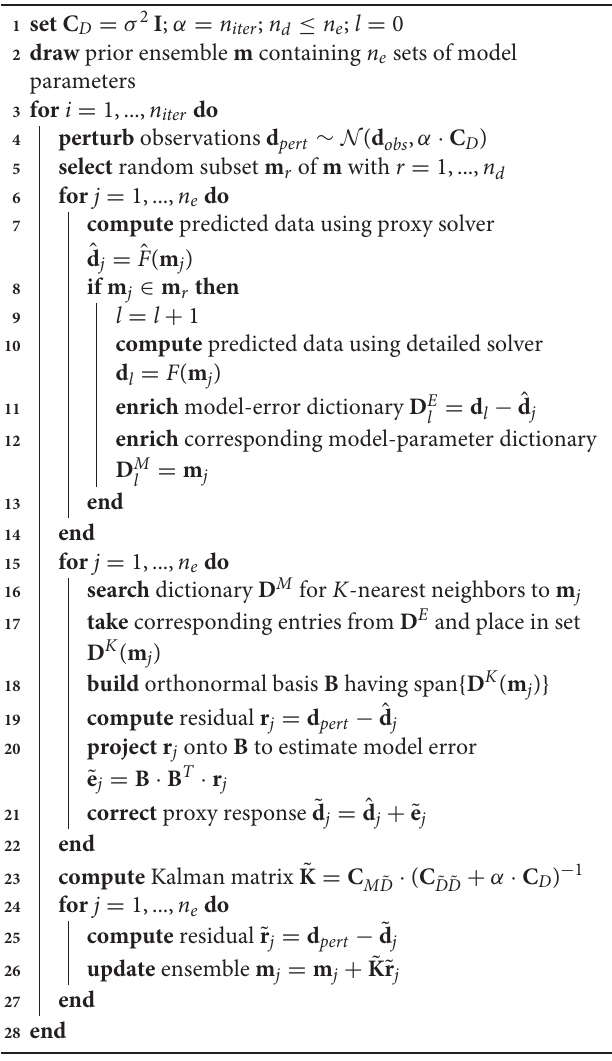
Algorithm 2: ES-MDA with model-error